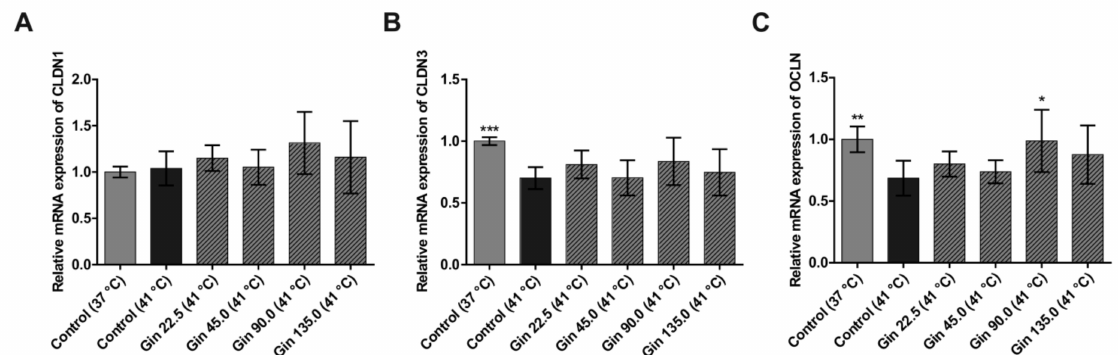
Figure 2. mRNA expression of tight junction protein genes in Caco-2 cells grown under normal temperature conditions (37 ◦ C) or under heat stress (41 ◦ C), without (Control) or with the addition of ginseng extract. The final concentrations of ginsenosides were 22.5 mg / L (Gin 22.5), 45 mg / L (Gin 45.0), 90 mg / L (Gin 90.0) and 135 mg / L (Gin 135.0). The expression levels of CLDN1 ( A ), CLDN3 ( B ) and OCLN ( C ) are indicated as fold-changes normalized to the control under the normal temperature condition of 37 ◦ C. Error bars are based on the standard deviation ( n = 6). *** p < 0.001, ** p < 0.01 and * p < 0.05 indicate significant di ff erences from the control under the 41 ◦ C heat stress conditions. Finally, we tested the potential positive e ff ect of ginseng extract on intestinal barrier